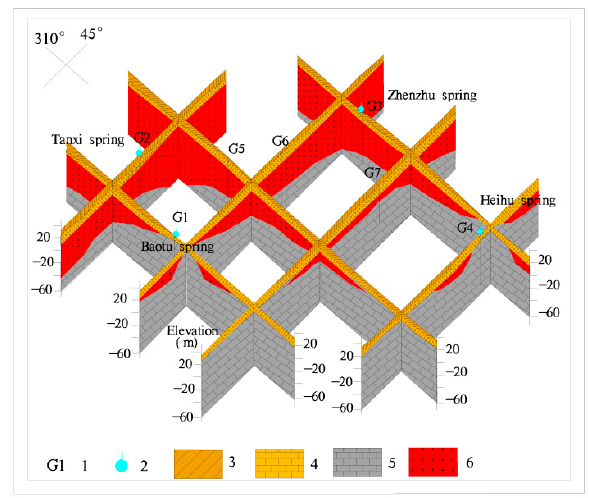
Figure 14. Geological three-dimensional structure of the spring. 1: boring number; 2: spring; 3: cohesive soil; 4: gravel layer; 5: limestone; 6: magmatic rock.